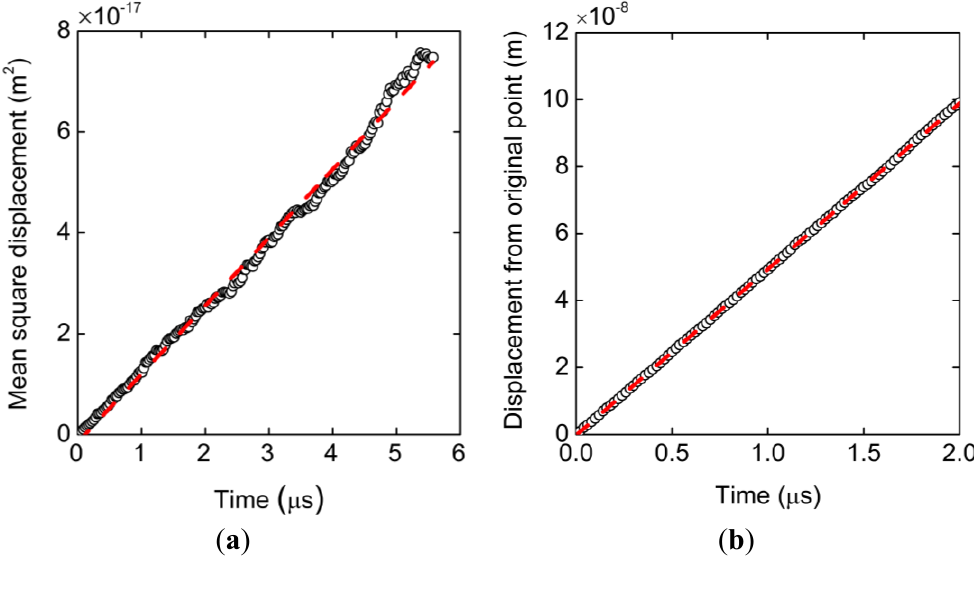
Figure 2. ( a ) Mean square displacement of the bead-spring model resulting from 90 simulation runs and ( b ) displacement of the mass center of the bead-spring chain under an electric field of 1 × 10 6 V/m obtained from 270 simulation runs. Each result is well fitted with straight lines by the least-squares method. The slope of plot ( a ) corresponds to the diffusion coefficient while that of ( b ) is the velocity that translates to the electrophoretic mobility.